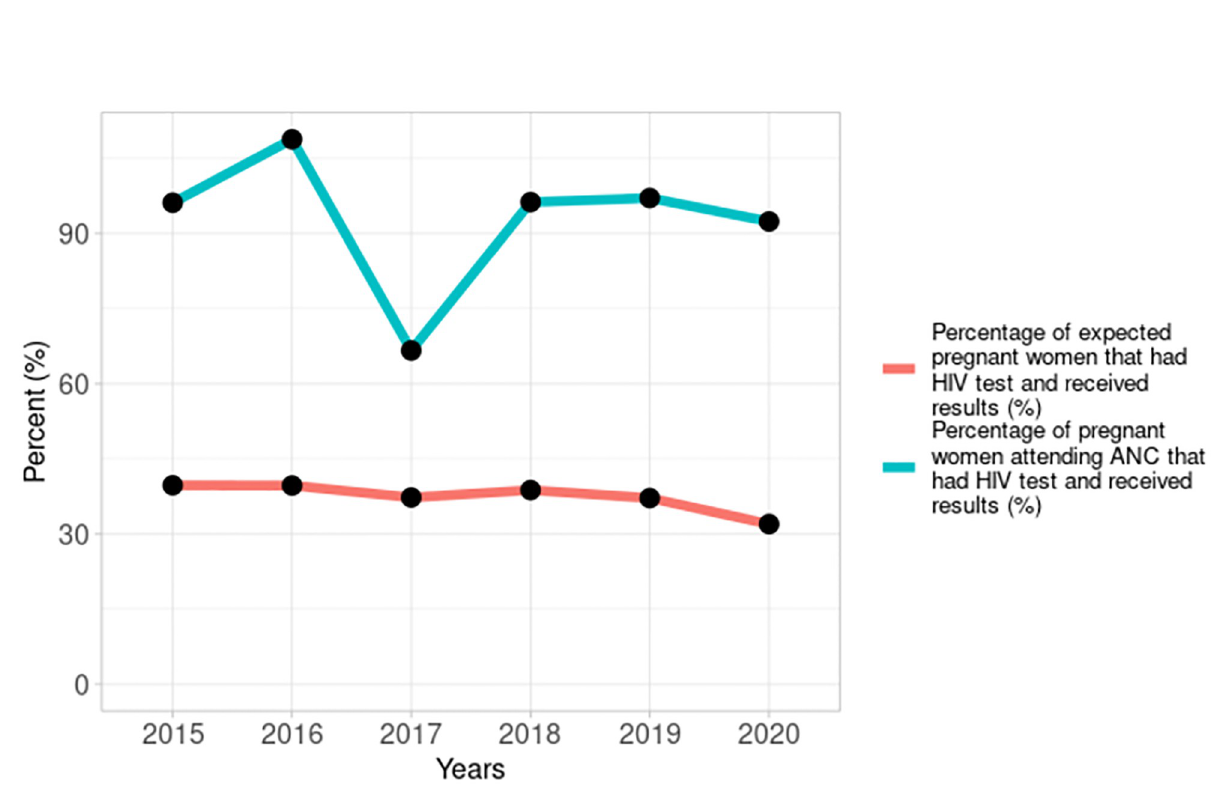
Fig 6. Percentage of pregnant women seen and tested, and percentage of estimated pregnant women tested annually from 2015–2020.